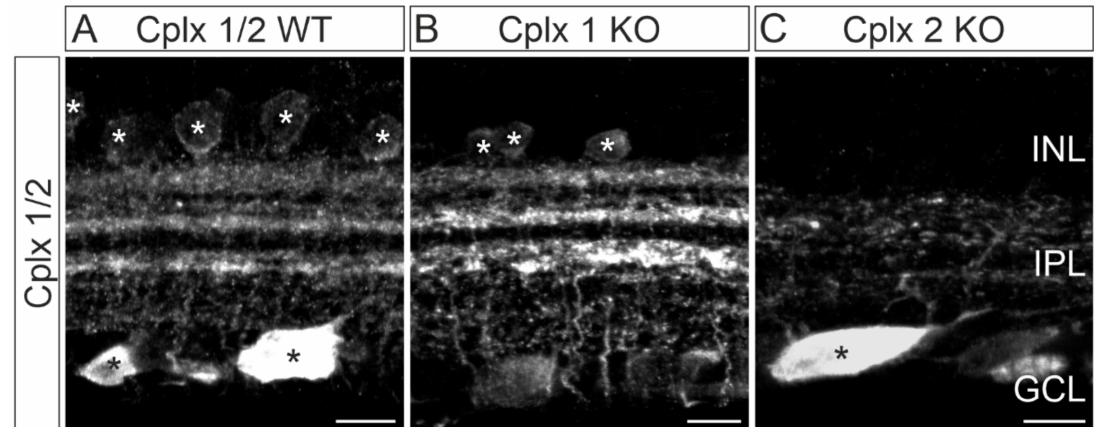
Figure 4. Distribution of Cplx 1/2 in wildtype (WT) and in Cplx 1 and Cplx 2 knockout (KO) mouse retinae. ( A – C ) Fluorescence micrographs of vertical vibratome sections through WT and Cplx 1 and Cplx 2 KO mouse retinae stained with an anti-Cplx 1/2 antibody. White asterisks in ( A , B ) mark labeled amacrine cell somata in the inner nuclear layer (INL); black asterisks in ( A , C ) mark strongly labeled ganglion cell somata in the ganglion cell layer (GCL). IPL, inner plexiform layer. Scale bars = 10 µ